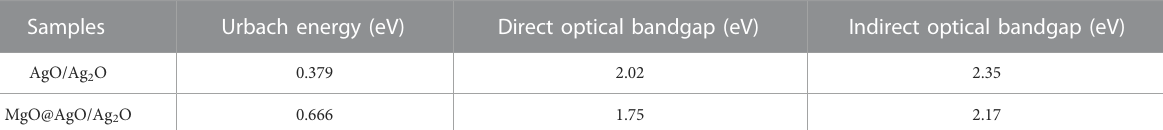
TABLE 3 Direct, indirect optical band gaps, and Urbach energies of synthesized NPs.